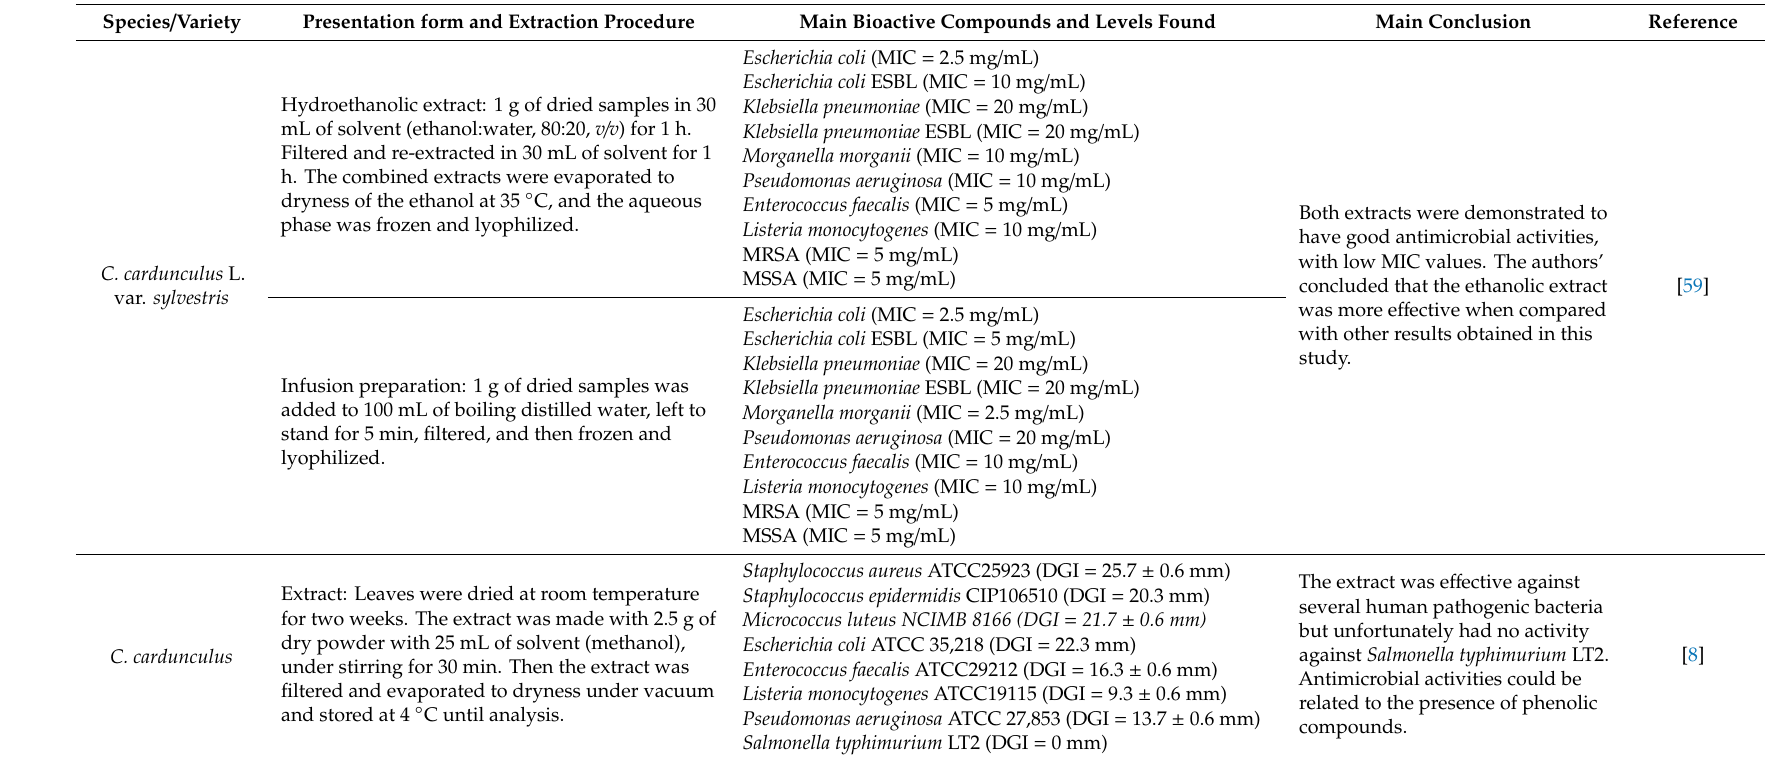
Table 2. Main antimicrobial activity of cardoon